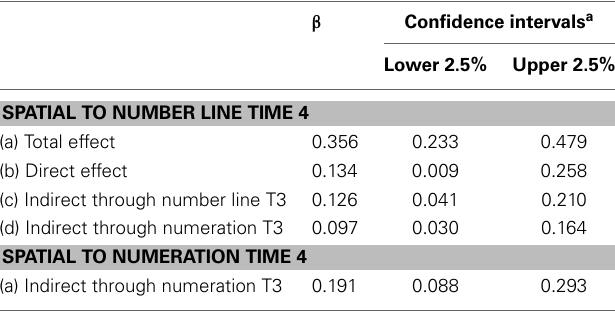
Table 4 | Significant effects (standardized) of spatial ability on number line and numeration at Time